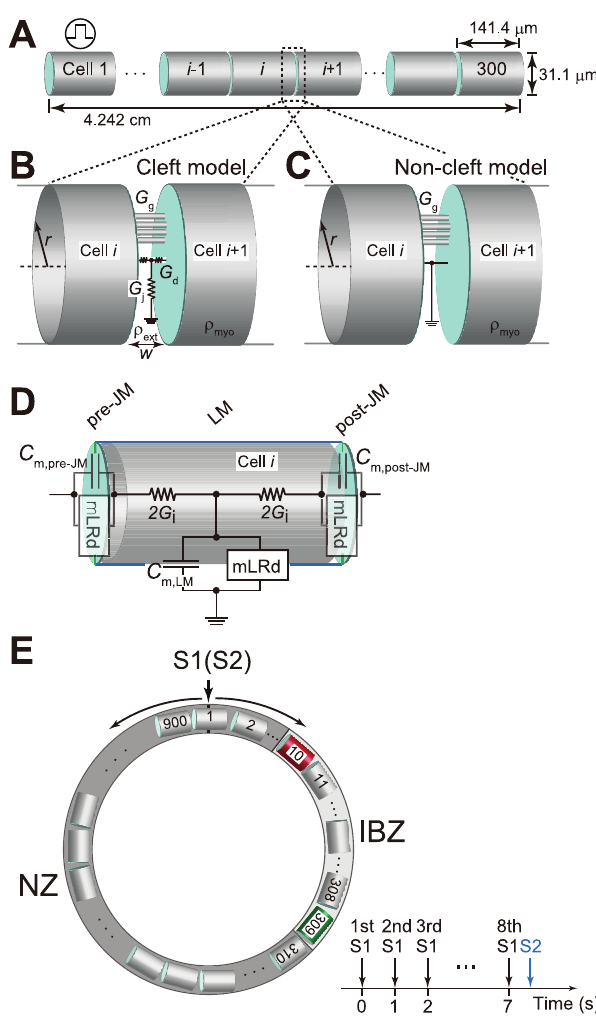
Figure 1. Cleft and non-cleft models of myocardial fibers and rings. (A), Schematic representation of a myocardial fiber comprising cylindrical 300 cells. (B) and (C), Schematic representations of the intercellular junction in the cleft (B) and non-cleft (C) models. (D), The AP of each membrane segment is represented by the modified Luo– Rudy dynamic (mLRd) ventricular myocyte model [24,25]. (E), Schematic representation of the myocardial ring comprising 900 cells (a), and the pacing protocol (b). G g , gap junctional conductance; G j , radial cleft conductance; G d , axial cleft conductance.